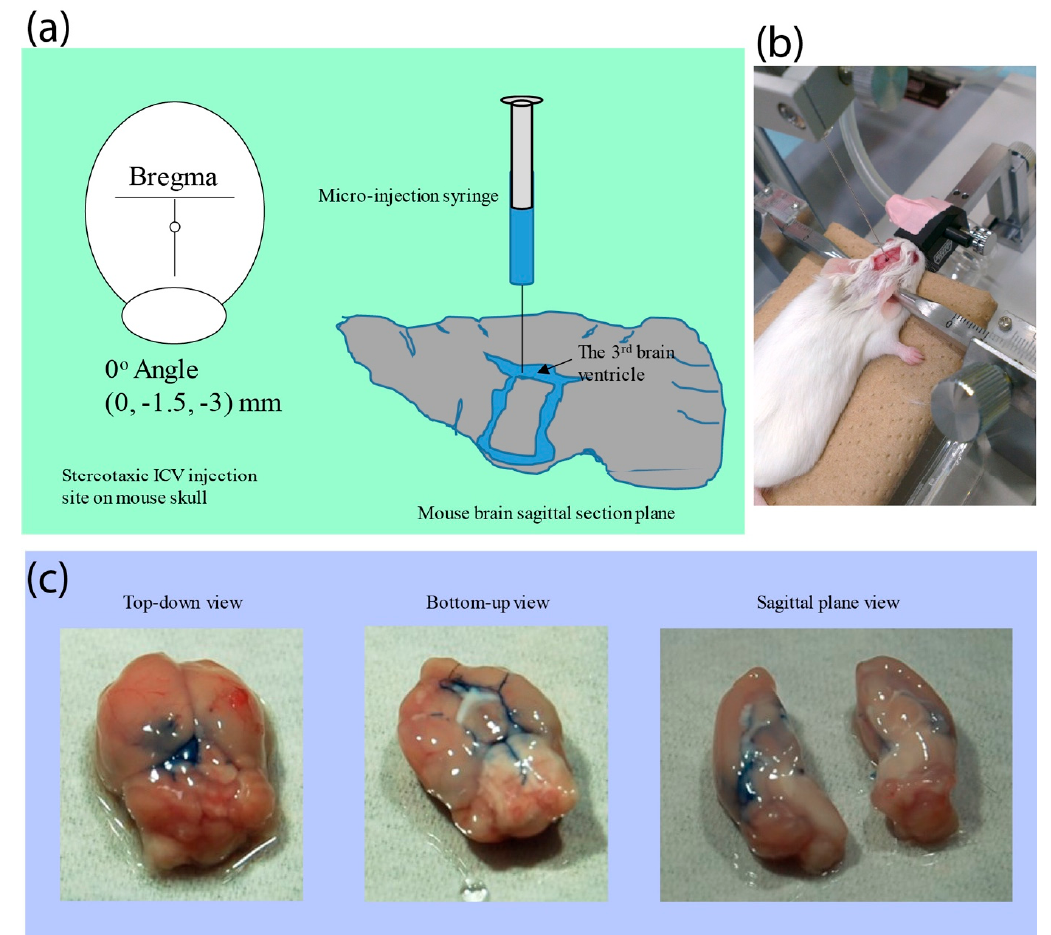
Figure 5. The ICV infusion of trypan blue to demonstrate the mixture solution would flow to whole brain via the connected brain ventricles. ( a ) Illustration of infusion site. ( b ) Intracerebroventricular infusion through micro-syringe. ( c ) Trypan blue flow to whole brain via the connected ventricles. To gain further insights into the Luc2 mRNA delivery efficiency via an ICV infusion mediated by PEG-polyamine block copolymers, the different repeating units of aminoethylene were administered as earlier mentioned. The Luc2 mRNA were mixed with 42K PEG-PAsp(DET), 42K PEG-PAsp(TET), and 42K PEG-PAsp(TEP) to assemble into polyplex nanomicelles, after which they were ICV infused in the mouse brains with non-packaged naked Luc2 mRNA serving as a negative control. The luciferase expression was then monitored by IVIS from 4 to 72 h post-infusion. As shown in Figure 6a, the brain infused with naked Luc 2 mRNA without PEGylated nanomicelle was observed to have emitted relatively weak luminescence at 4 h post-infusion mark, while the infusion of non- packaged mRNA did not emit any luminescence. Interestingly, luciferase expression from all self- assembly polyplex nanomicelles delivered Luc 2 mRNA exhibited luminescence signatures throughout the entire 4–48-h post-infusion time-course. Of these, the 42K PEG-PAsp(TEP) showed the most significant luciferase expression when compared with the other three groups. The